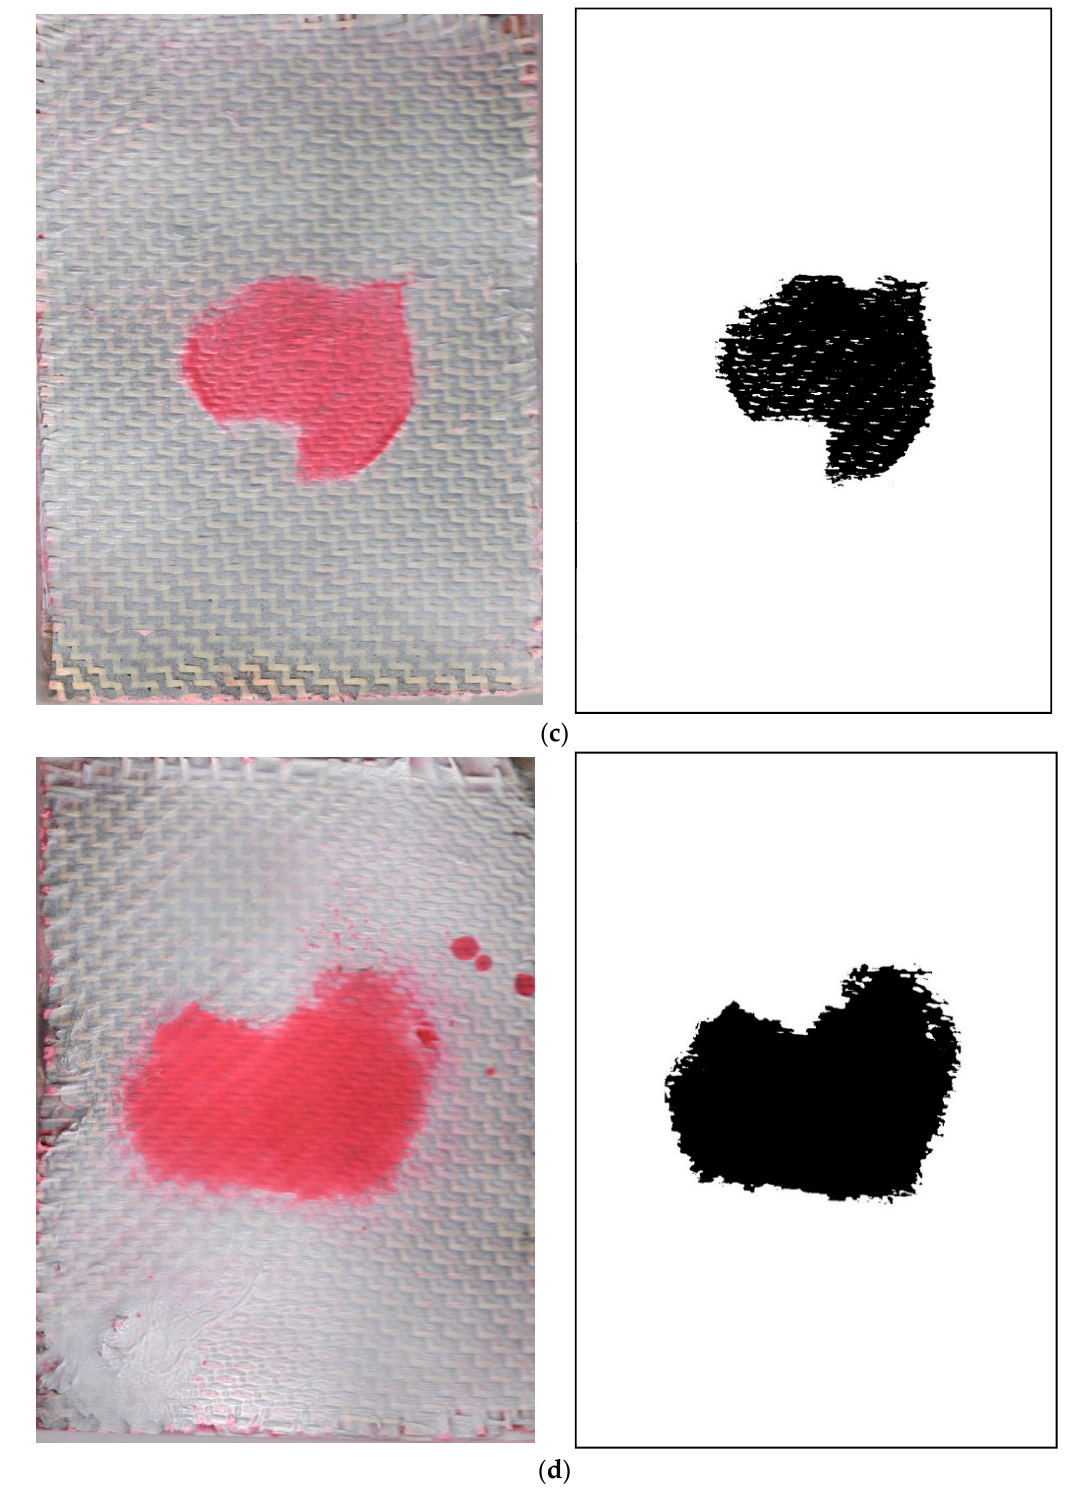
Figure 9. Damage area of impacted specimens of the banana/epoxy sandwich structure with respect to different impact energy levels: ( a ) 5 J, ( b ) 10 J, ( c ) 15 J, and ( d ) 20 J.